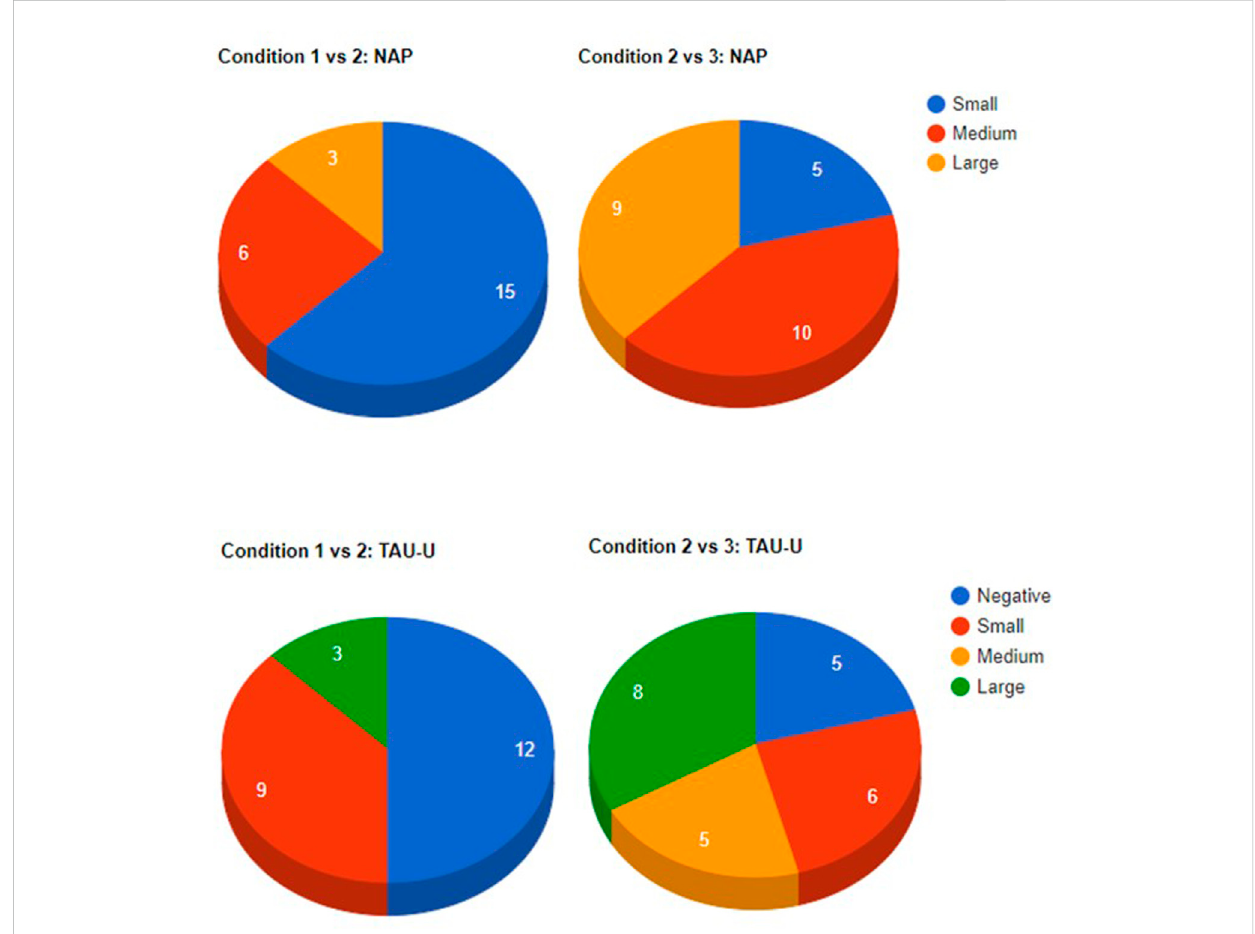
FIGURE 1 The top piecharts show thenumberof participants in eachNAP effect size category whencomparingConditions 1(no intervention) with Condition 2 (standard teaching) and Condition 2 with Condition 3 (robot intervention). The bottom pie charts show number of participants in each effect size category for TAU-U. NAP scores can range from 0 to 1, where values less than 0.66 are considered no or small effect, values between 0.66 and 0.92 a medium effect, and values of 0.93 and above a large effect. The same cut-off values were applied to TAU-U. Note that TAU-U values could also be negative, indicating that a condition change resulted in lower latencies as opposed to higher